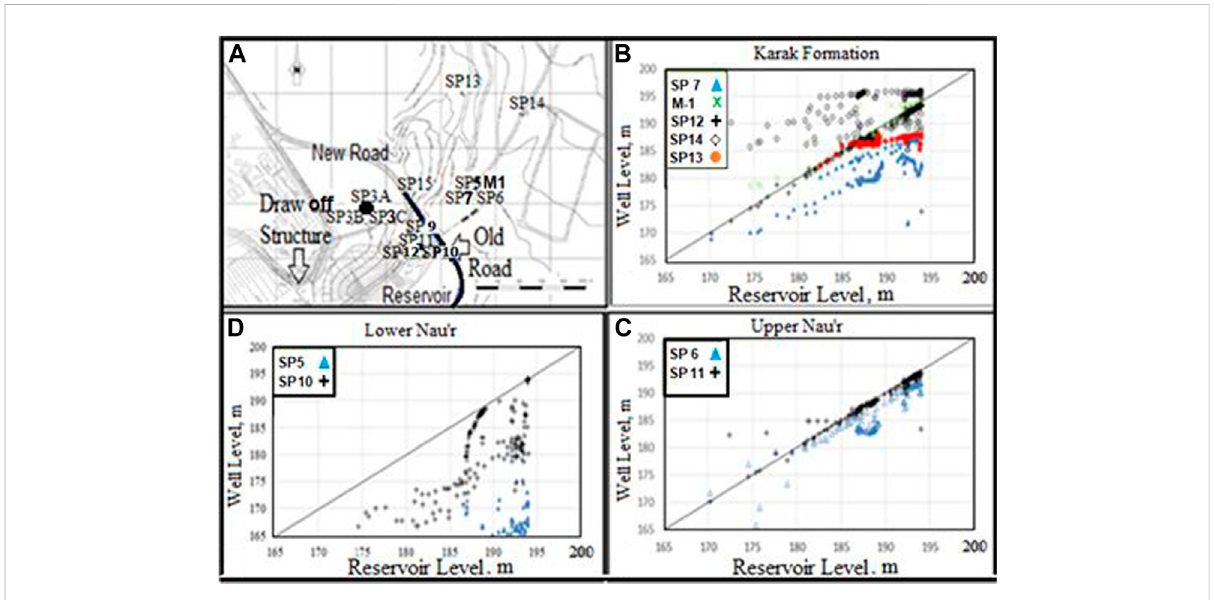
FIGURE 8 Correlation plots of right abutment wells level with the reservoir level. (A) Wells location, (B) The wells tapping Karak formation, (C) The wells tapping upper Na ’ ur formation, and (D) The wells tapping the lower Na ’ ur